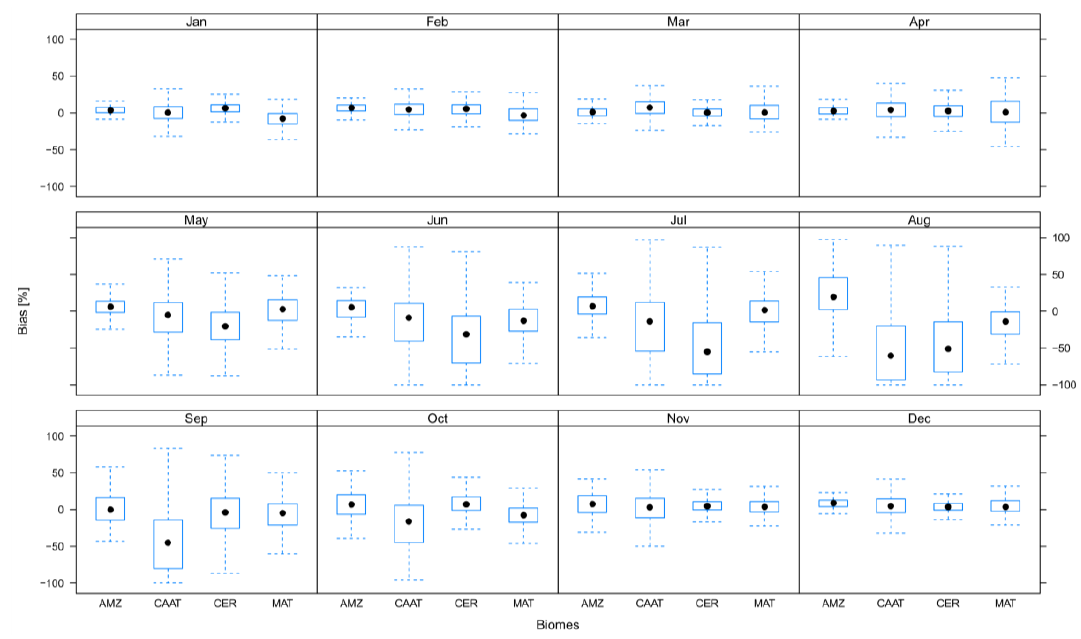
Figure 10. As per Figure 8, but for the CHIRPS rainfall product.